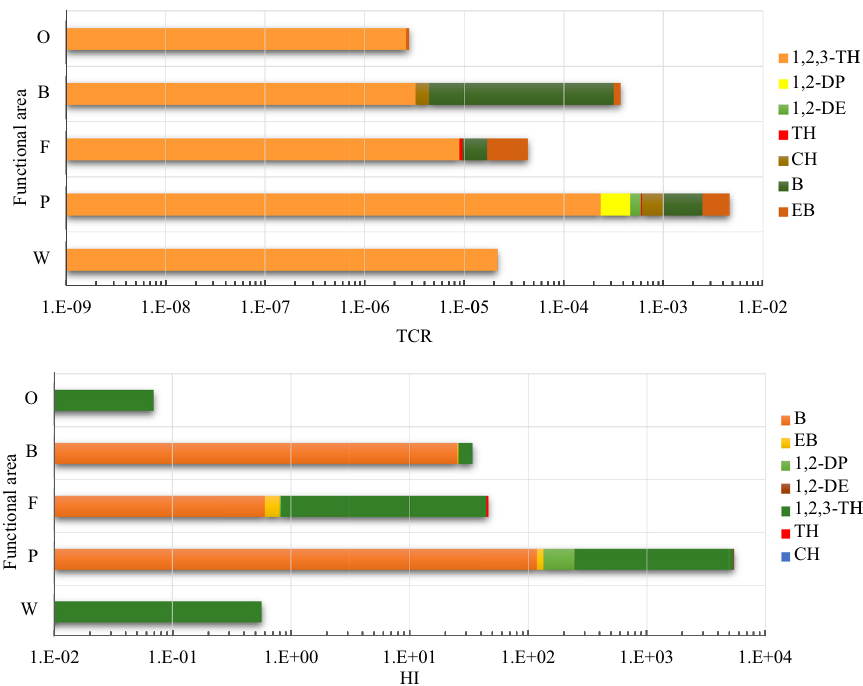
Figure 4: The TCR and HI from VOCs in chemical site soils. Note that the horizontal axis was the logarithmic